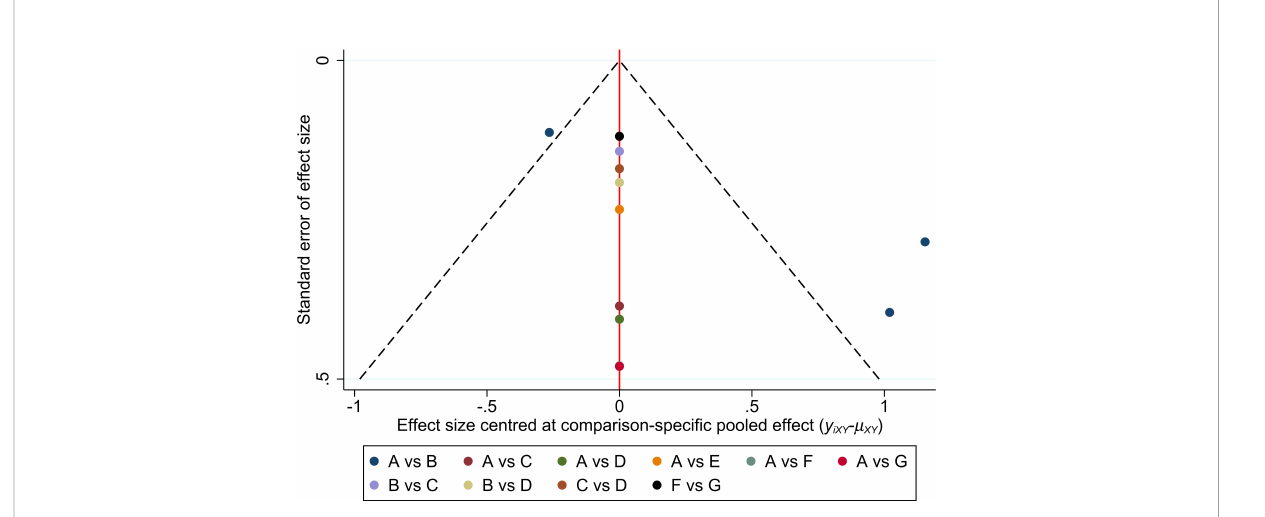
FIGURE 5 Comparison-adjusted funnel plot. A: placebo; B: TNF- a Etanercept; C: IL-17A Secukinumab LD; D: IL-17A Secukinumab HD; E: IL-17A Ixekizumab; F: IL-23 Ustekinumab LD; G: IL-23 Ustekinumab